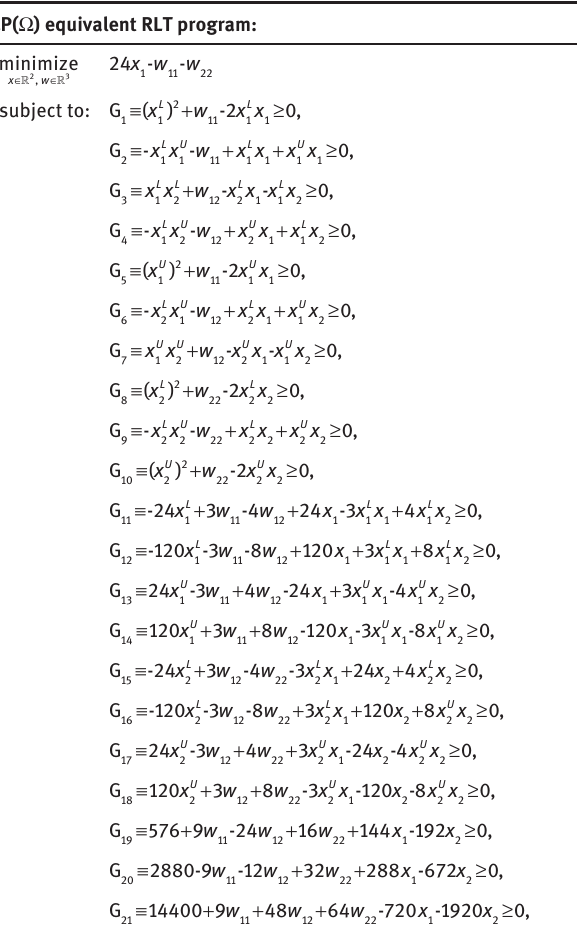
Table A1: Reformulated linearized program of Example